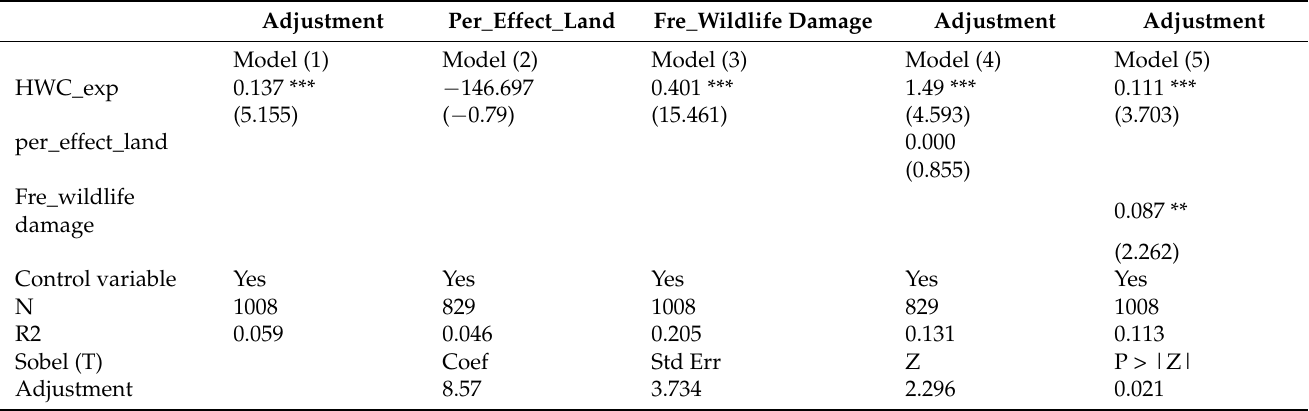
Table 8. Results of the mediation effect